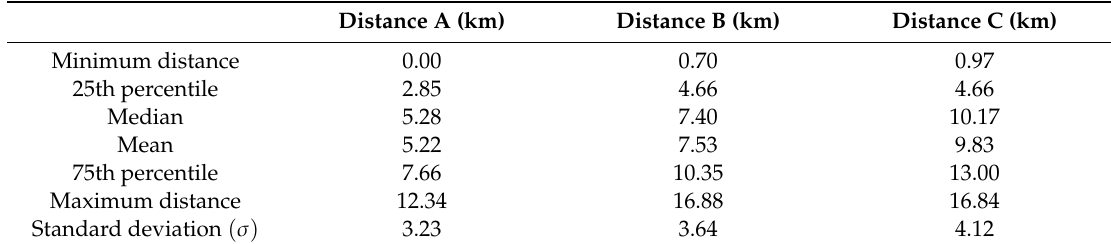
Table 2. Distances between FS strokes and the maximum stroke density (Distance A), maximum precipitation rate (Distance B), and the maximum 24-h accumulated rainfall (Distance